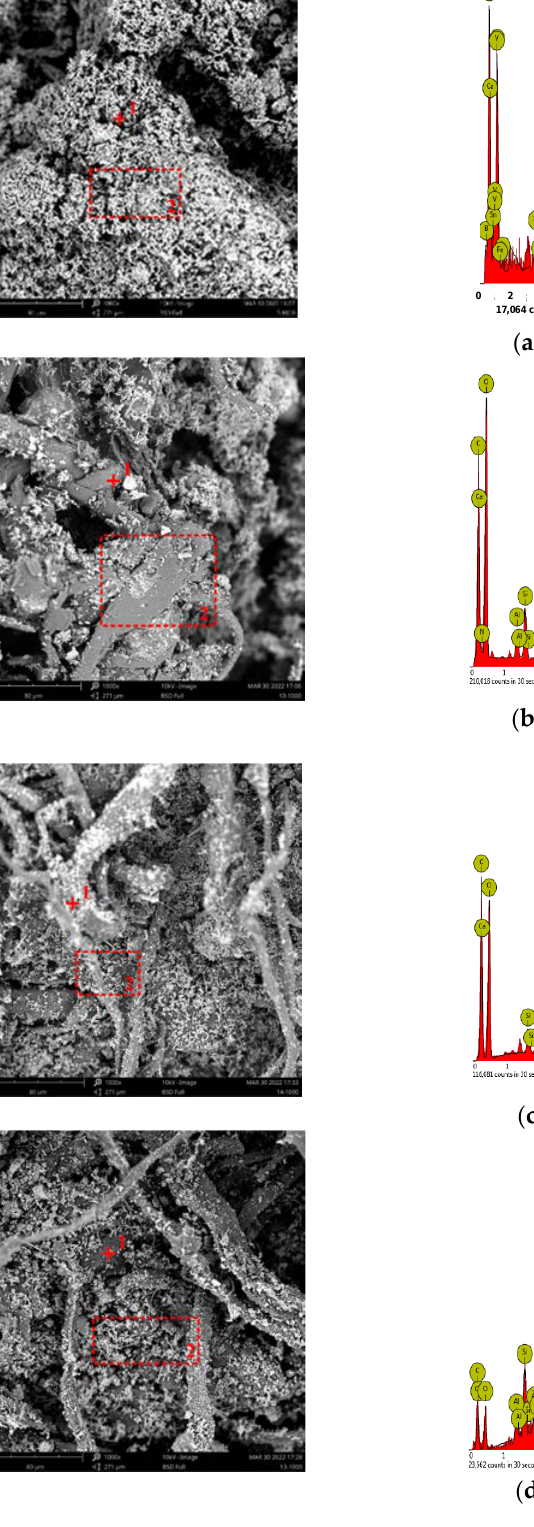
Figure 12. SEM of cement mortar with different waste PE (×1000) (day 7, W/B ratio of